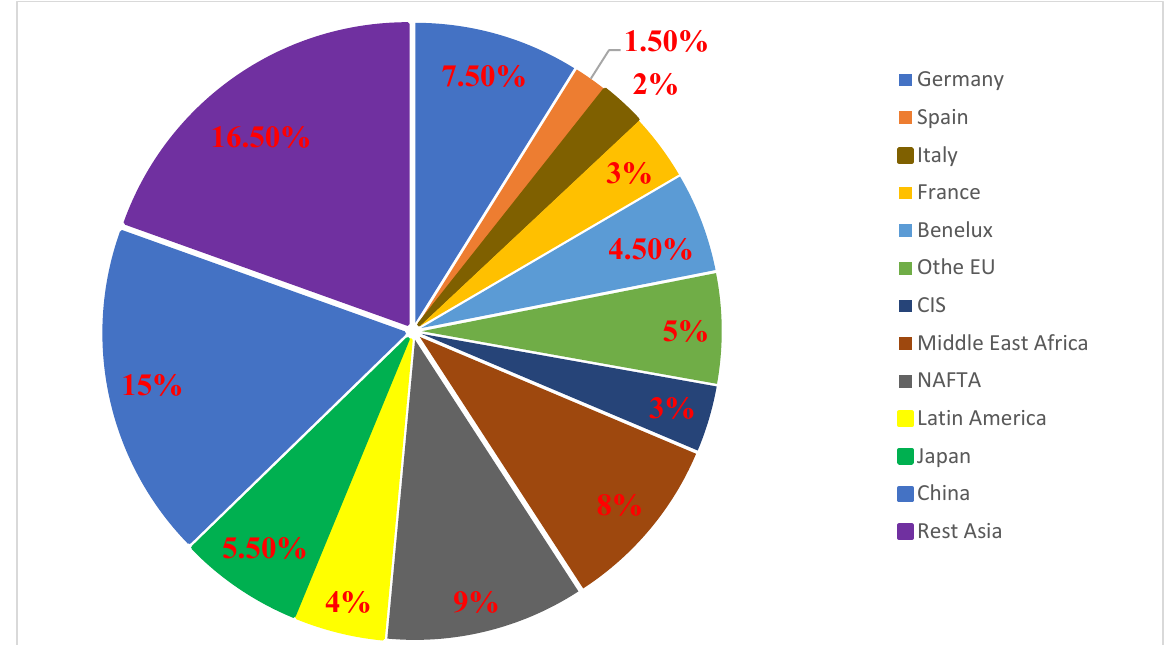
Figure 1. Global Production of Plastics: Data Source [17].